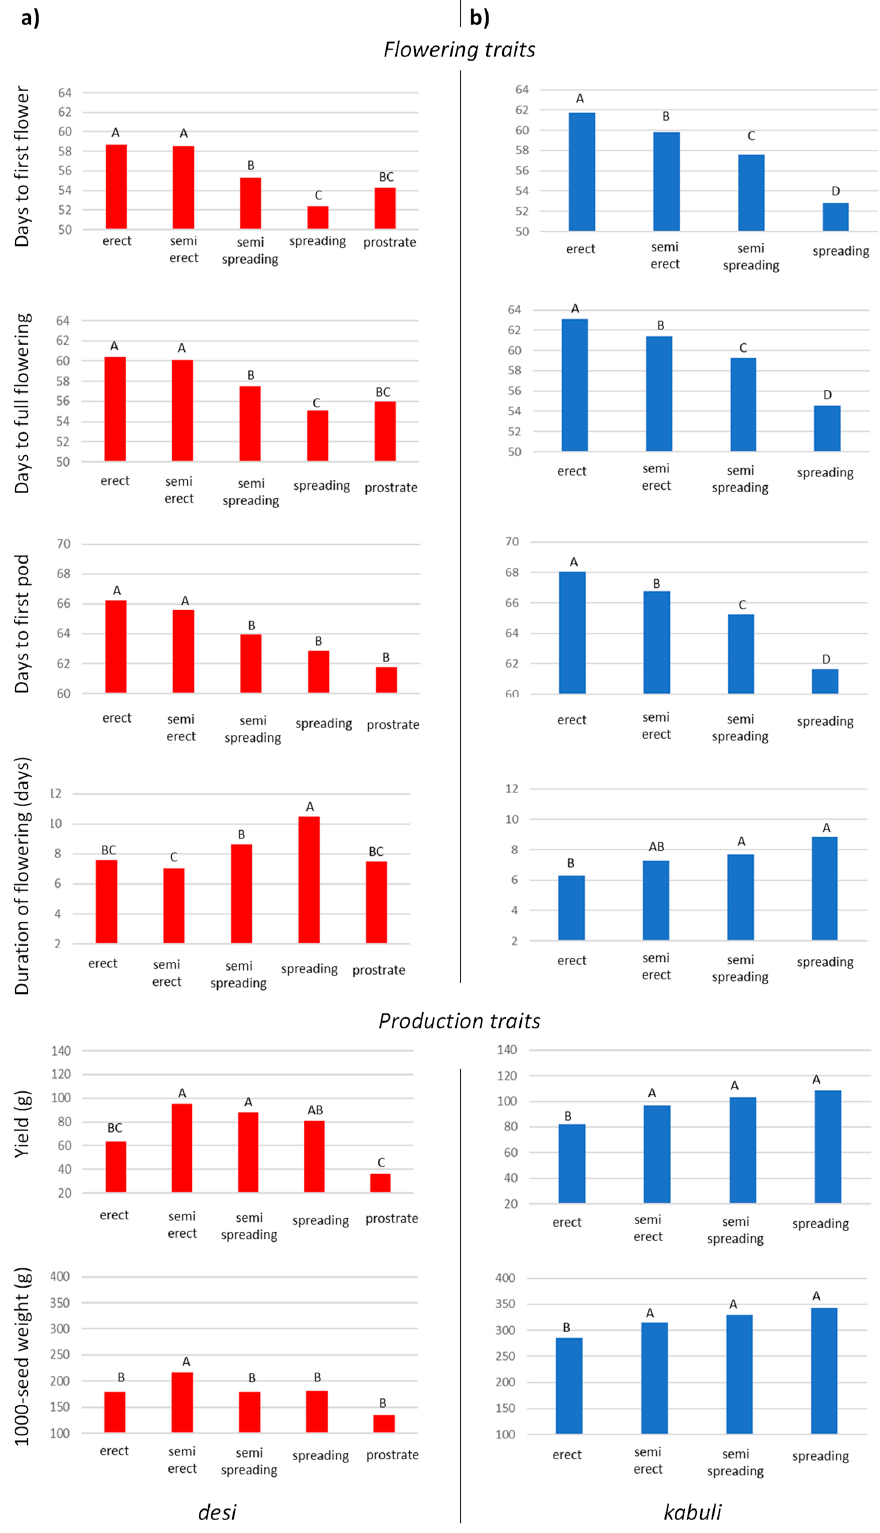
Figure 7. One-way ANOVA for the growth habit classes for flowering and production traits of the UNIVPM_Ca_core2 panel for the desi ( a ) and kabuli ( b ) types. Data are means for each growth class. Different capital letters above the columns in each plot indicate significant differences between clusters for that growth class ( p < 0.05; Student’s t -tests).